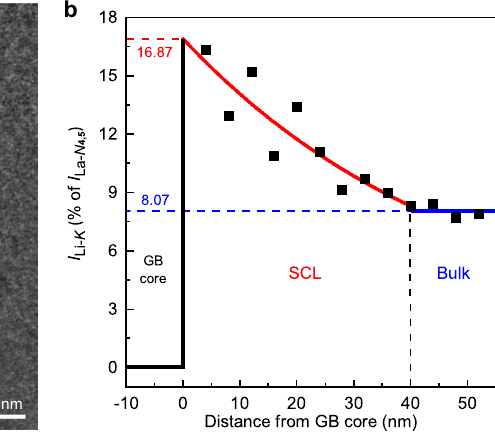
Fig.2|Lidistributioninthevicinityofthegrain-boundarycore.a HAADF-STEM imageoftheregionselectedfortheEELSline-scanexperiment.GBstandsfor “ grain boundary ” . The arrow indicates the direction where the EELS line scan was con- ducted. b VariationofthenormalizedLi- K intensity, I Li- K ,withthedistancefromthe grain-boundary (GB) core. SCL represents “ space-charge layer ” . The solid squares